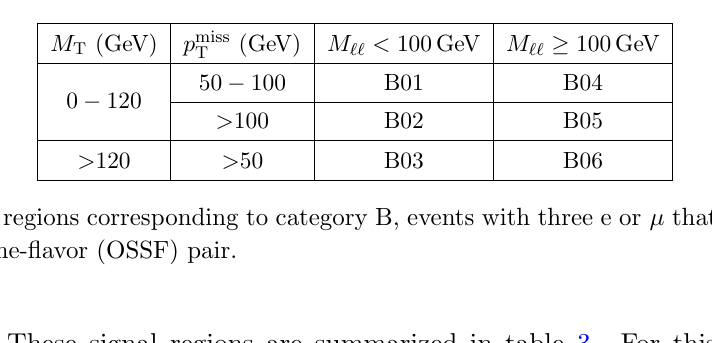
Table 2 . Search regions corresponding to category A, events with three electrons or muons that form at least one opposite-sign same-(cid:13)avor (OSSF) pair. Search region A15 y overlaps with the WZ control region of the analysis, and is not used in the interpretation.